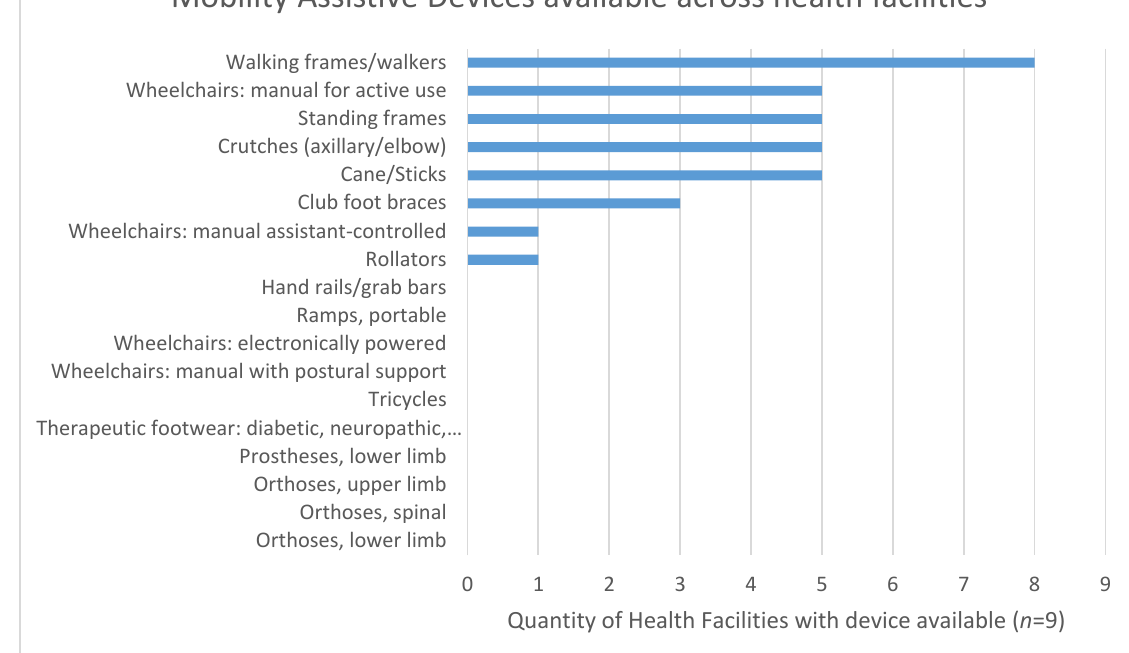
Figure 2. Availability of assistive devices by proportion according to the Global Co-operative Assistive Technology (GATE) Assistive Products List (APL).